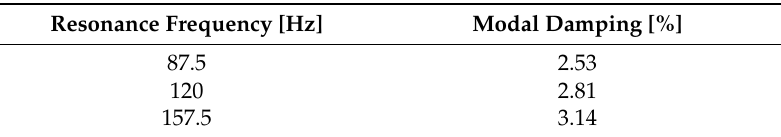
Table 5. Modal damping